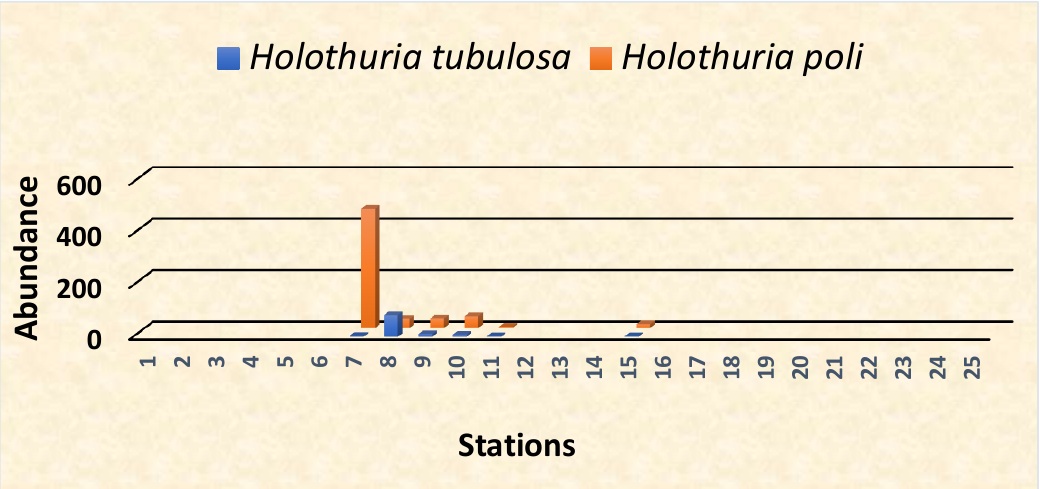
Figure 3. Abundance of the Holothuria species as identified in the sampling location. Two Holothuria species were recorded: Holothuria poli and Holothuria tubulosa .